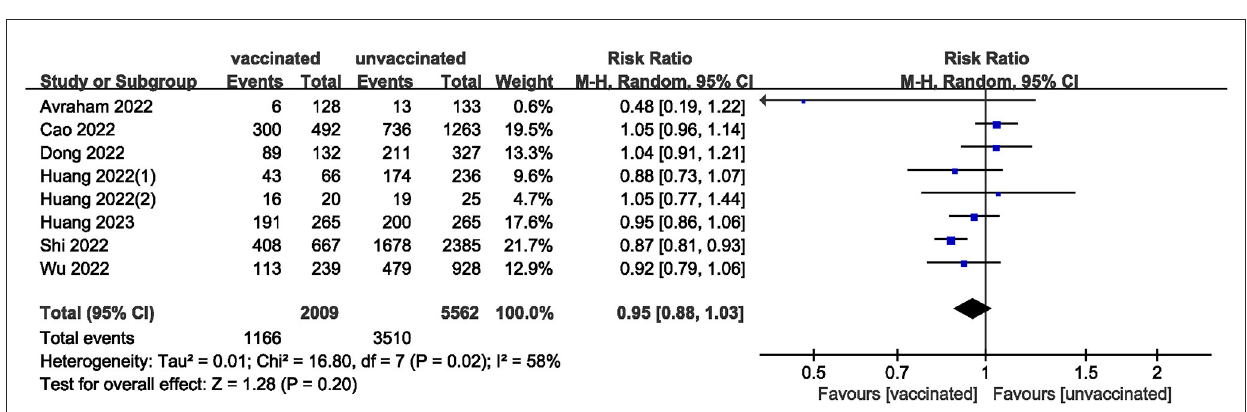
FIGURE3 Forest plot of biochemical pregnancy rate for vaccinated vs. unvaccinated.